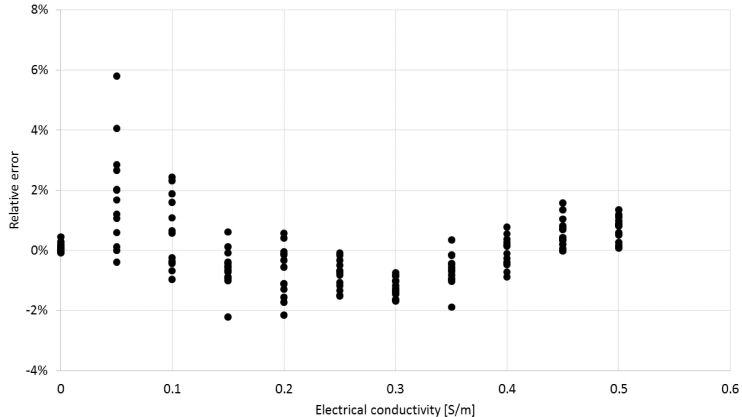
Figure 10. The relative error of electrical conductivity determination from Equation (3) for the simulated